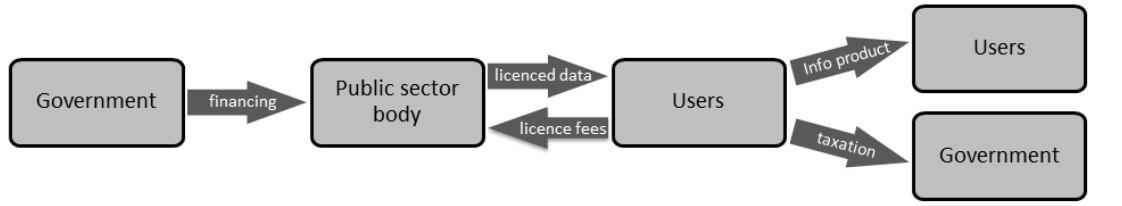
Figure 1: Cost recovery policy for data (P. Boers (personal communication April 17, 2015) after van Loenen 2006, p.106)